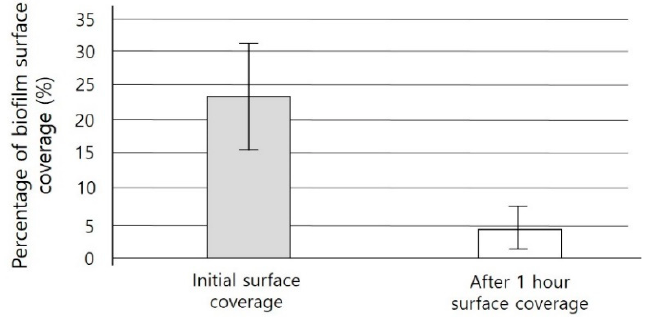
Figure 7. Percentage of the surface biofilms between control (initial) and BE treated (after 1 h) images (n = 6). Table 2. Surface coverage of biofilms in control and BE-treated (after 1 h) images. # of Sample